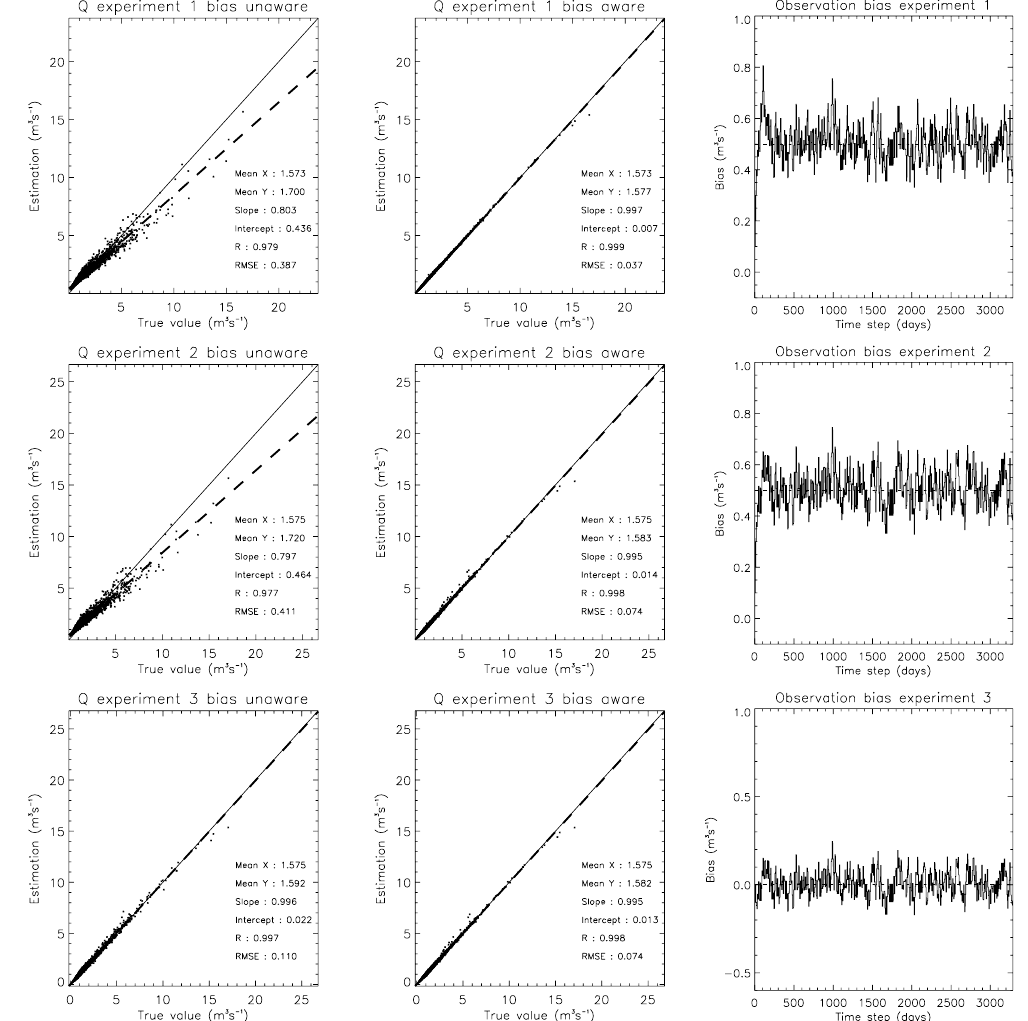
Fig. 7. Comparison of the estimated discharges obtained using the bias-aware and a bias-unaware EnKF, and the evolution of the observation bias throughout the simulation – both for the constant observation bias experiment. The dashed lines are the regression lines; the solid lines the 1:1 line. For the bias estimation, the dotted lines refer to the true